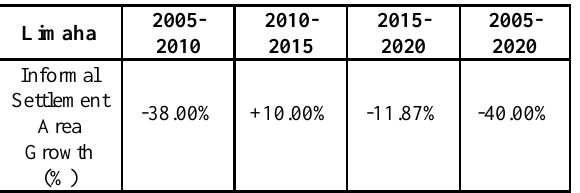
Table 3. Informal Settlement Growth in Percentage in Brgy. Limaha